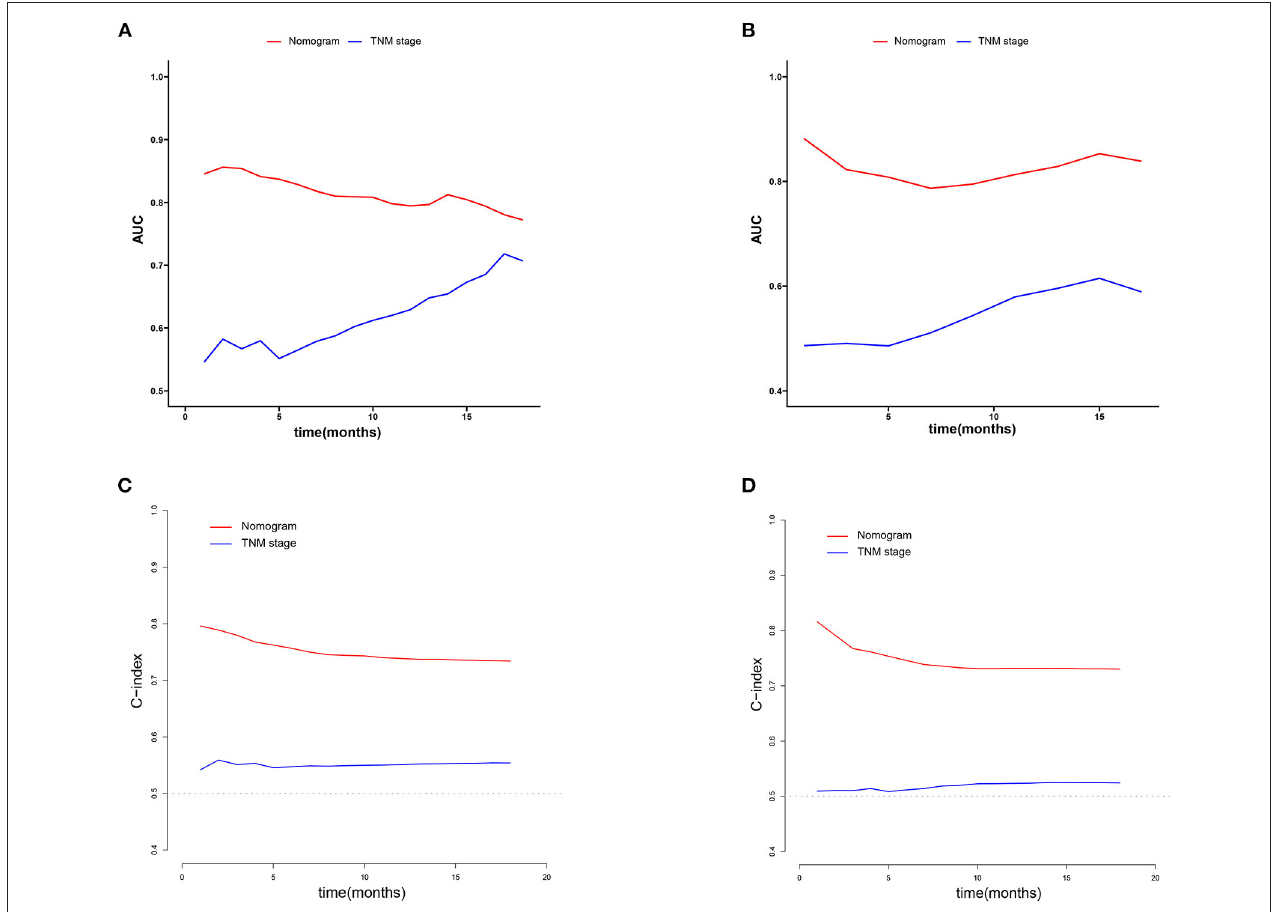
FIGURE 8 | Time-dependent ROC and C-index curves of overall survival. (A,B) The time-dependent ROC curves corresponding to 1–15 months in the training cohort and the verification cohort. (C,D) The time-dependent C-index curves corresponding to 1–20 months in the training cohort and the verification